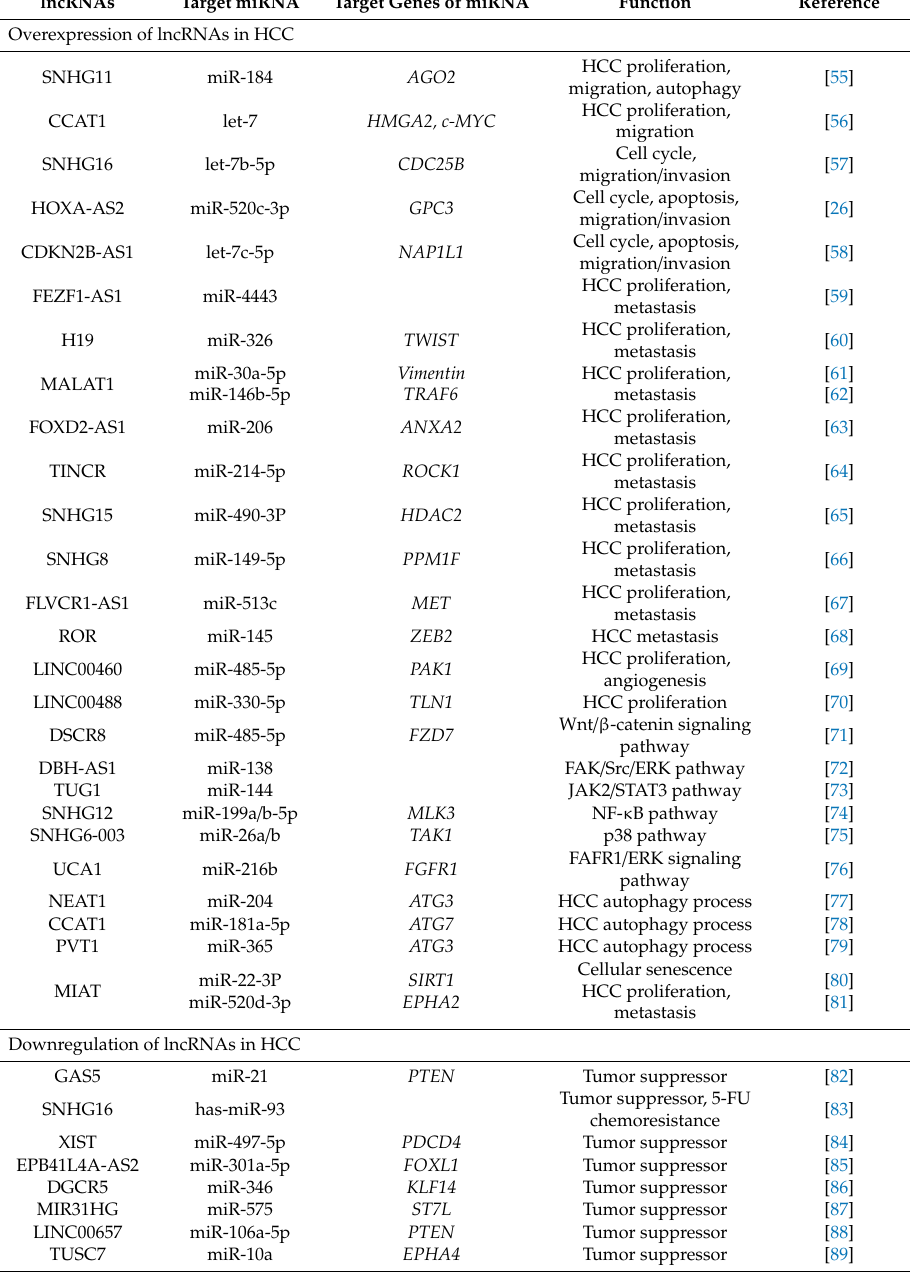
Table 1. Long non-coding RNA and microRNA networks in